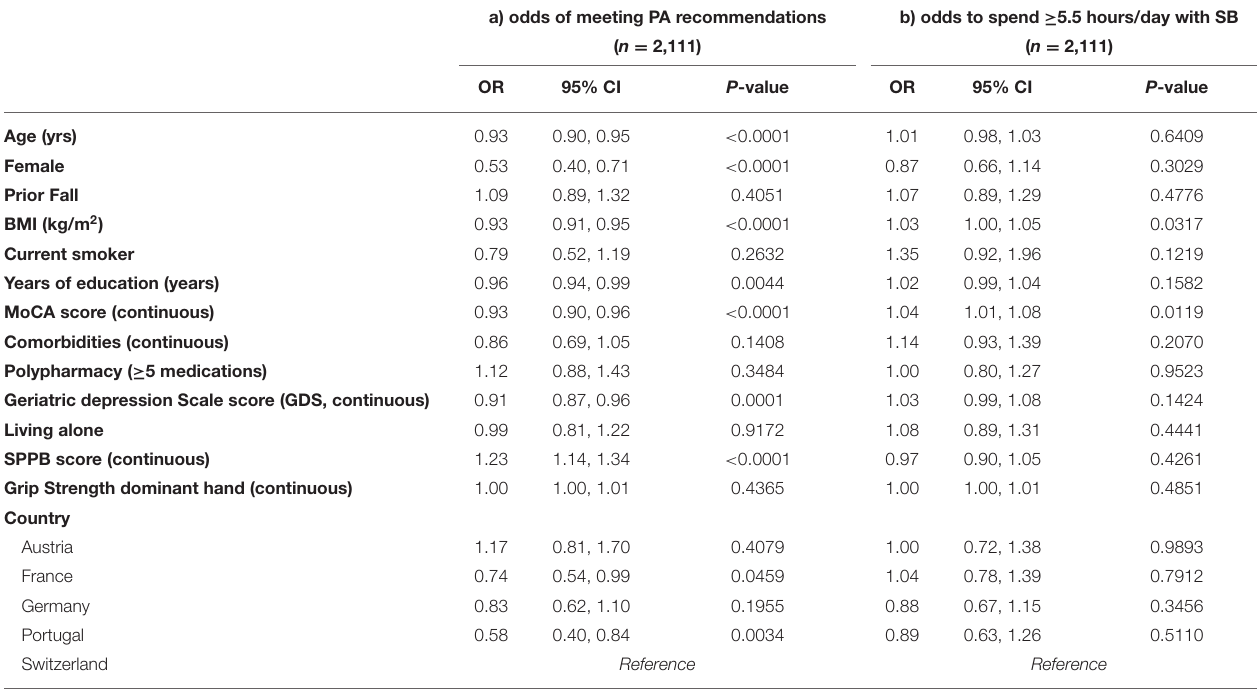
TABLE 2 | Multivariate logistic regression models, a) odds of meeting PA recommendations at baseline, b) odds of spending ≥ 5.5 hours/day with SB at baseline. a) odds of meeting PA